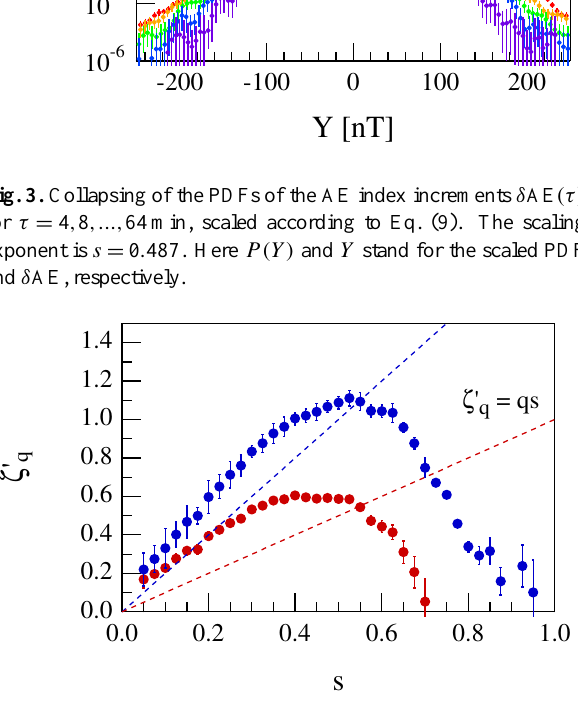
Fig. 4. Plot of ζ 0 ( q ) vs s for the determination of the scaling parameter s in the range Y ∈ [45 , 55] nT for q = 1 (red circles) and q = 2 (blue circles), respectively. The two dashed lines refer to ζ 0 ( q ) = qs with q = 1 (red) and q = 2 (blue), respectively.